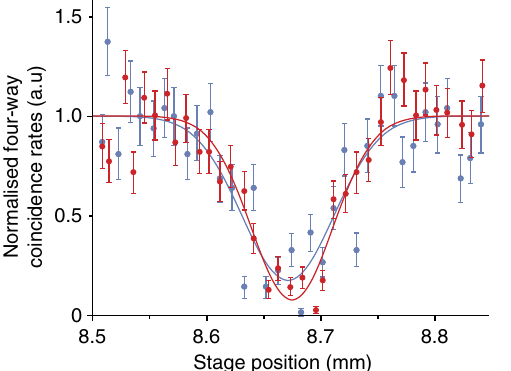
Fig. 4 A detailed schematic of the experimental setup. L1000: lens of focal length 1000mm. L75: lens of focal length 75 mm. BBO0: 0.5-mm-thick β -barium borate crystal. L100: lens of focal length 100 mm. BF1: two consecutive bandpass fi lters at 405 ± 5 nm. SF: 100- μ m circular aperture. L50: lens of focal length 50 mm. BBO1: 1-mm-thick β -barium borate crystal. DM: dichroic mirror. BBO2: 1-mm-thick β -barium borate crystal. LF: longpass fi lter, cutoff wavelength 750 nm. L150: lens of focal length 150 mm. L300: lens of focal length 300 mm. SLM: spatial light modulator. L400: lens of focal length 400 mm. BF2: bandpass fi lter at 808 ± 1.5 nm. BF3: bandpass fi lter at 810 ± 10 nm. L200: lens of focal length 200 mm. TS: translation stage. BS: non-polarising beamsplitter. L2: lens of focal length 2 mm. SMF: single-mode fi bre. MMF: multi-mode fi bre. SPAD: single-photon avalanche diode 1.0